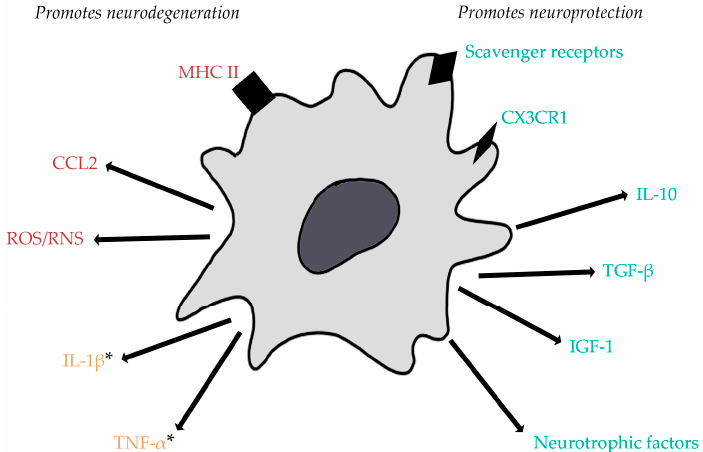
Figure 2. Expression and release of factors by activated microglia can promote neurodegeneration or neuroprotection in situations of central nervous system (CNS) autoimmunity.